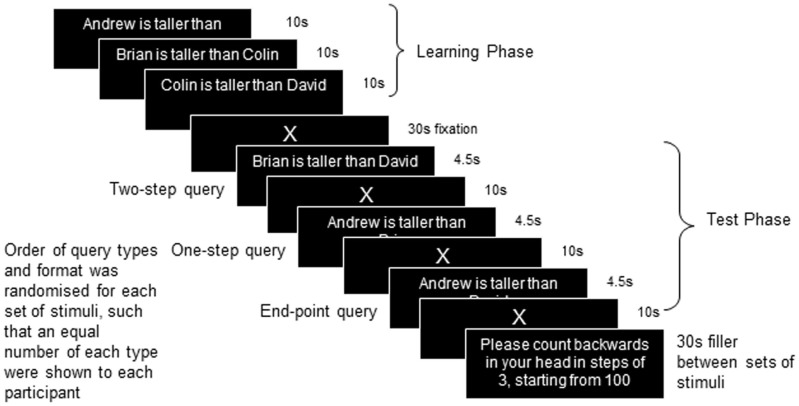
Design of the study.